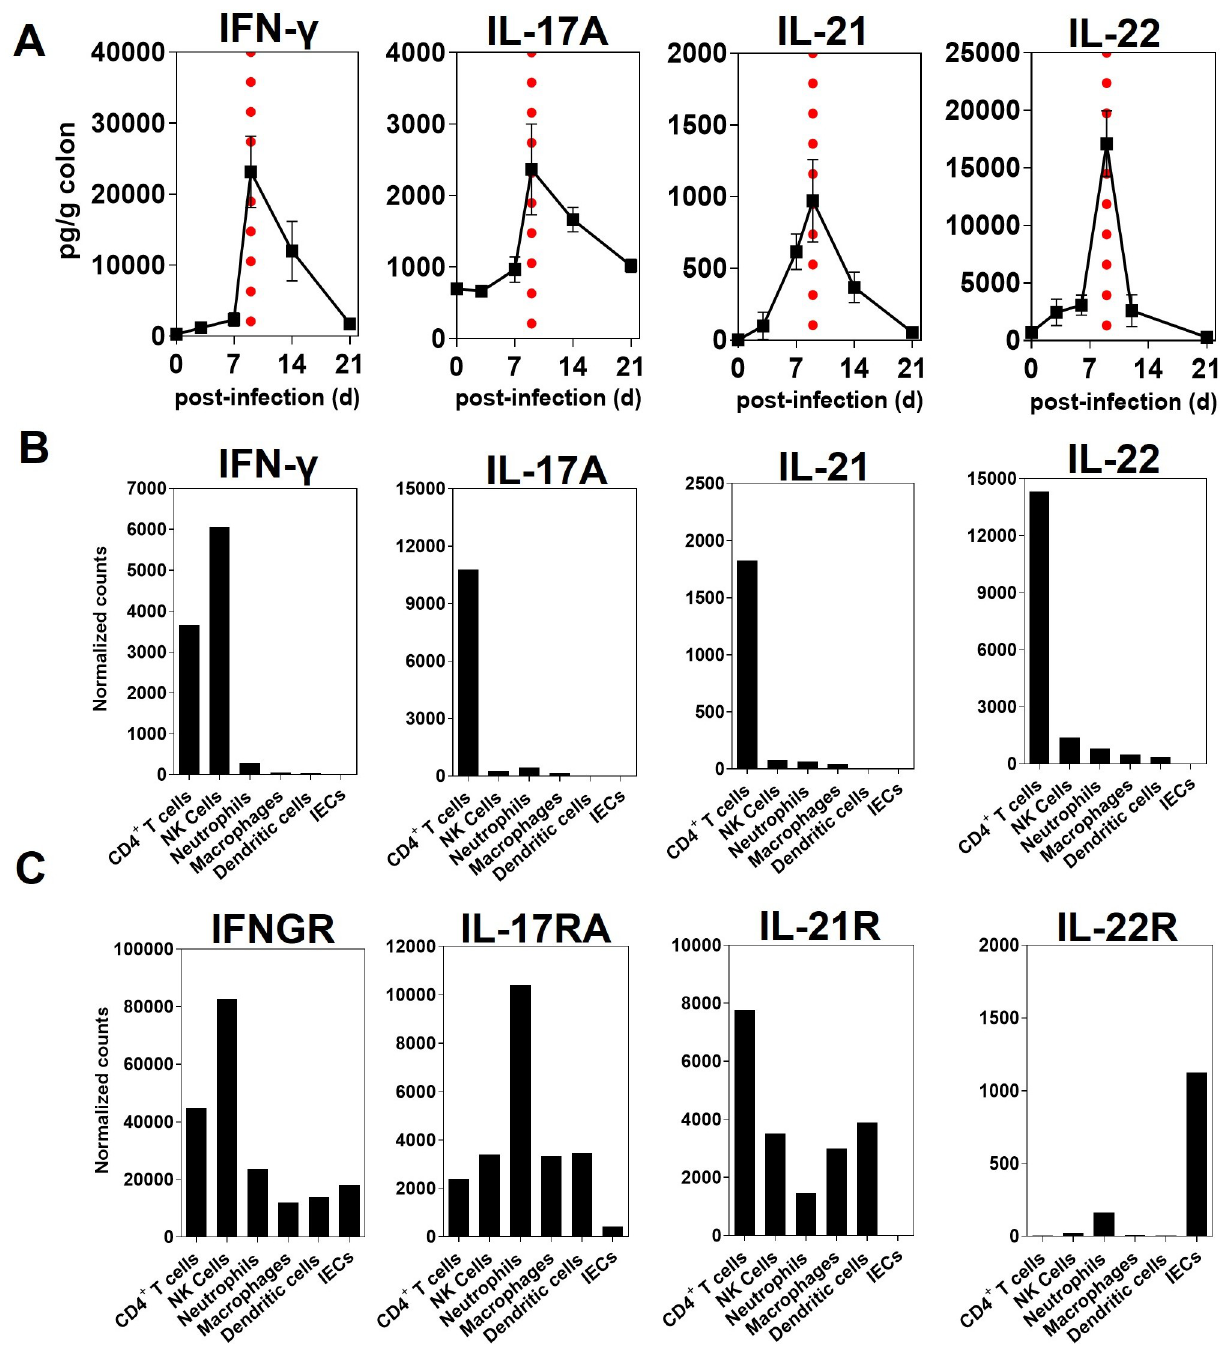
Fig 2. IL-21 is induced in the distal colon following infection with C . rodentium . A . Cytokine ELISA of the indicated cytokines from supernatants of the ex-vivo organ culture of the colonic tissues from WT mice collected at different time-points p.i. (48 hr cultures). Data are Mean ± SEM from two or more experiments ( n = 7 mice/time-point). Day 9 after infection is indicated by vertical dashed lines. B . The mRNA expression of indicated cytokines (IFN- γ , IL-17A, IL-21, and IL-22) and C . Cytokine receptors (IFN- γ R, IL-17RA, IL-21R, and IL-22R) by immune cells in the LP and non-immune epithelial cells (IECs) in the pooled distal colon of WT mice ( n = 25) 9 days after infection with C . rodentium analyzed by Nanostring.